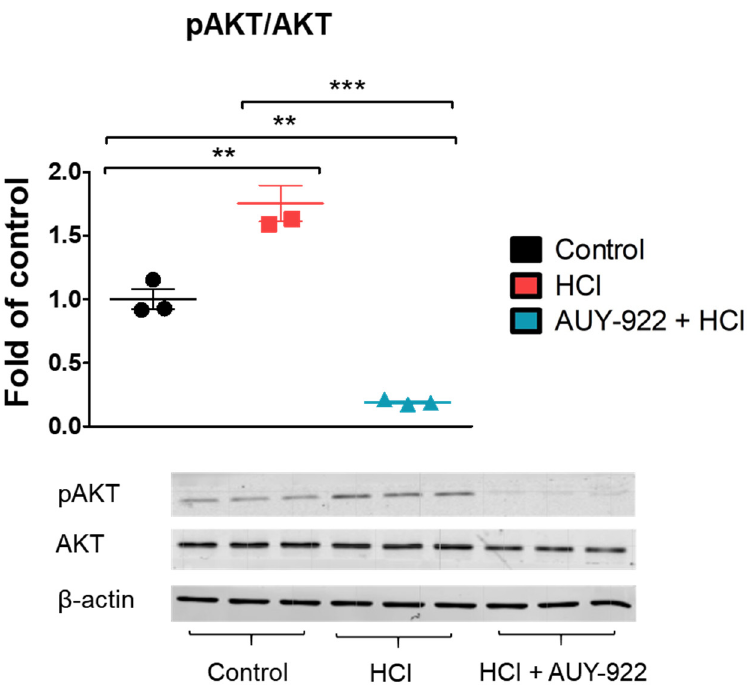
Figure 4. The HSP90 inhibitor, AUY-922, prevents the HCl-induced AKT phosphorylation. HLMVEC grown in 100 mm cultured dishes, were pre-treated for 24 h with 2 µM AUY-922 and then exposed to 0.01 N HCl. One hour later, cells were lysed, and samples were prepared for protein analysis by Western Blotting. Means ± SEM; n = 3; **: p <0.01; ***: p < 0.001 with one-way ANOVA and Tukey’s.